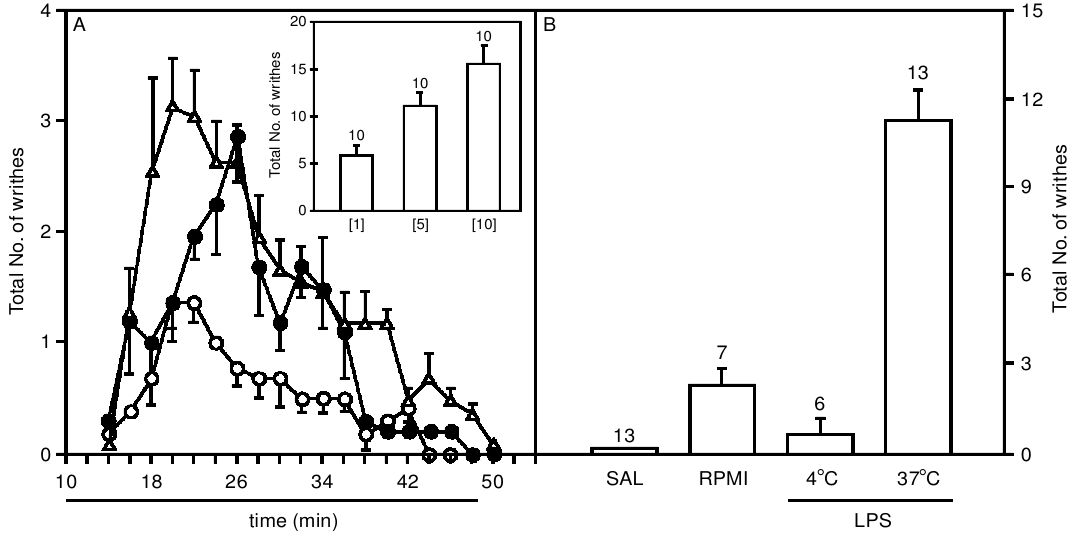
FIG. 1. Nociceptive effect of the supernatant of LPS-stimulated macrophages (MNF, macrophage nociceptive factor). (A) Time course (10 - 50 min) of the nociceptive response induced by different doses of MNF: n , 1 ml / g body weight; d , 0 · 1 ml / g; s , 0 · 01 ml / g). The insert in (A) shows the total number of writhes determined in the interval between 14 and 34 min after injection of MNF at doses of 0 · 01 ml / g body weight [1], 0 · 1 ml / g [5] and 1 ml / g [10]. (B) Number of writhes induced by i.p. injeciton of: SAL, saline; RPMI, supernatant of macrophages incubated with medium alone; LPS 4 8 C/LPS 37 8 C, supernatant of macrophages stimulated for 30 min with LPS (5 m g / ml) and incubated at 4 8 C or at 37 8 C (0 · 1 ml / g body weight). The number of writhes was determined in the interval between 14 and 34 min after MNF injection. In all panels the number at the top of each bar represents the number of mice in that experimental group. The results are reported as means SEM. , Statistically signi® cant differences (P , 0 · 05) between the group and the control group (SAL) determined by ANOVA and Bonferroni’s